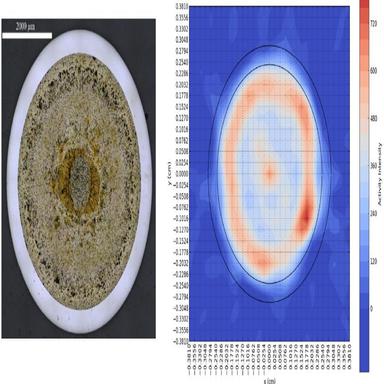
2D tomographic reconstruction of Cs-137 distribution at the axial middle height of X501-G591 (right) and correspondent optical microscopy image.